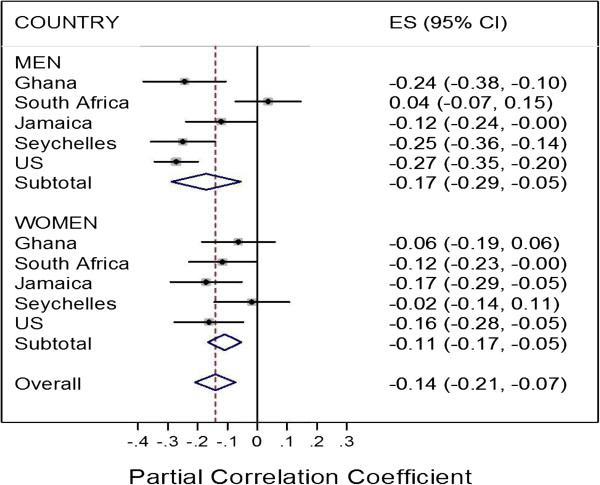
Forest plots describing partial correlation coefficients for relationship between MVPA and BMI among participants enrolled in METS: men overall r = -0.17, women overall r = -0.11, combined overall r = -0.14.